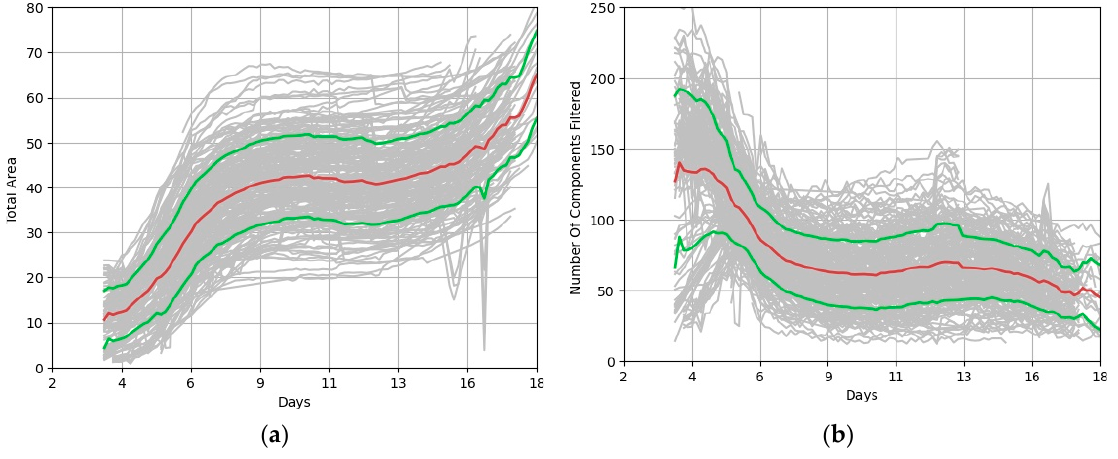
Figure 12. Results of morphological analysis: covered area percentage ( a ), number of filtered components ( b ). The brown line represents the medium value, the green line represents standard deviation. Other results of the morphological analysis are provided in the Appendix